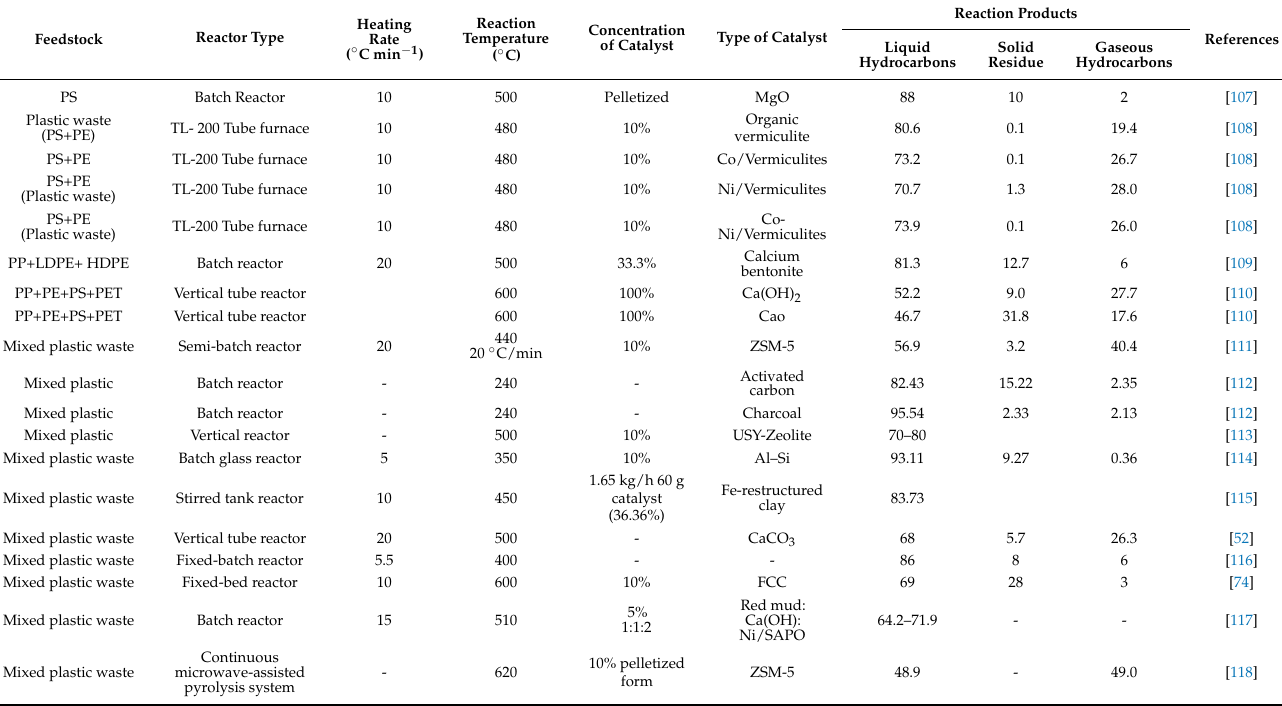
Table 3. Catalytic effect on the liquid, solid, and gaseous